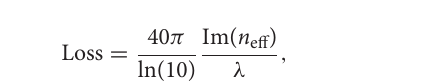
first or third transmission band. In Figure 3 , we use Equation (2) to plot the antiresonant tube thickness as a function of wavelength, λ , and the refractive index, n 1 . Figure 4 shows the confinement loss of simple and nested negative